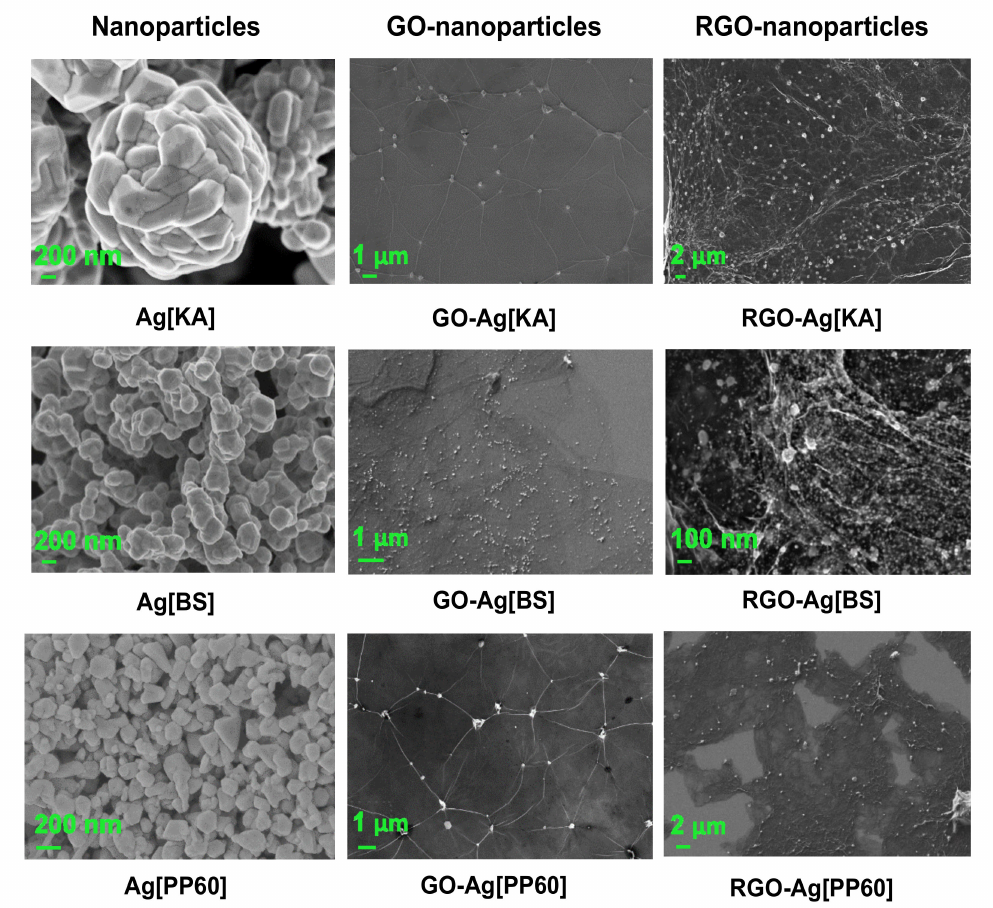
Figure9. SEMimagesofnano-Ag—Ag[KA],Ag[BS],andAg[PP60]nanoparticles—andtheircomposites with GO and RGO. Di ff erent magnifications were used for the best presentation of the morphology of each